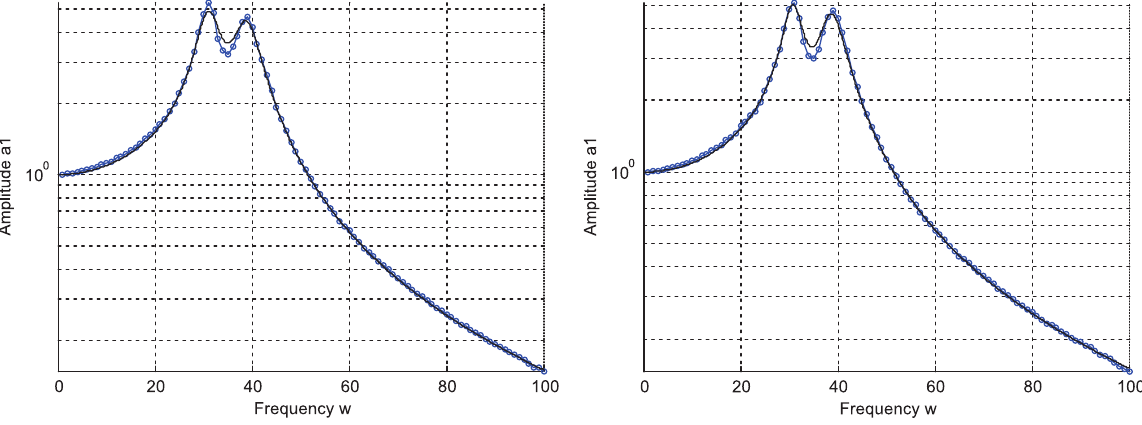
Fig. 4. Comparison of the amplitude-frequency curves of DVBG DVA by the analytical method (solid line) and the numerical one (circle line).